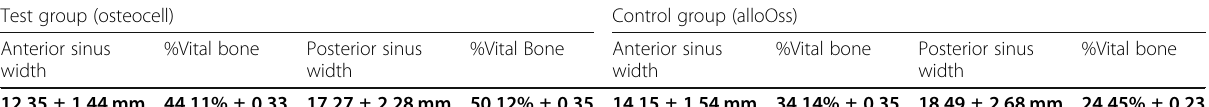
Table 1 The difference between test and control group on four variables: anterior sinus width and vital bone, posterior sinus width, and vital bone Test group (osteocell) Control group (alloOss) Anterior sinus %Vital bone width